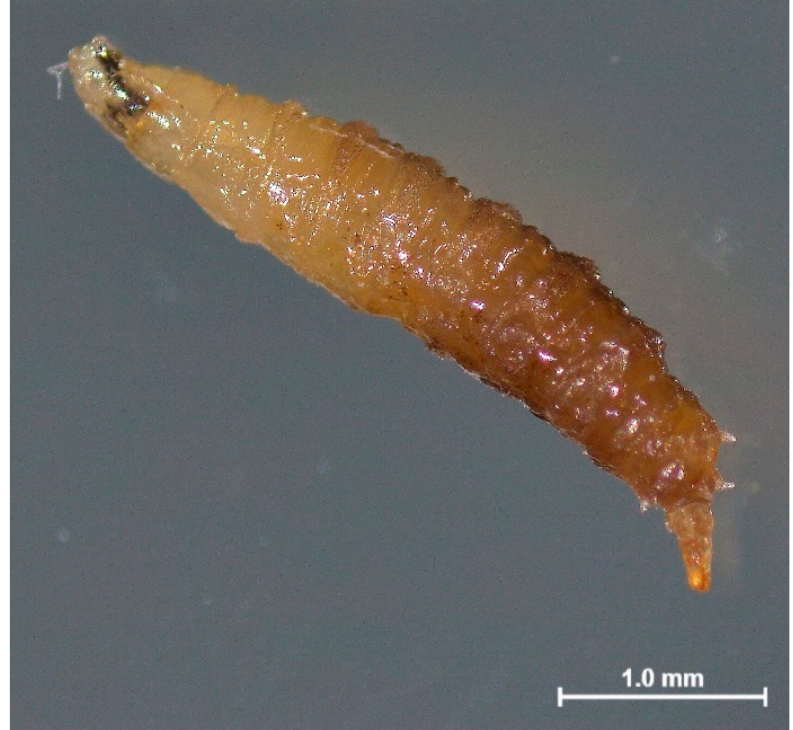
Figure 1. Microscopic image of Drosophila suzukii (larval stage).